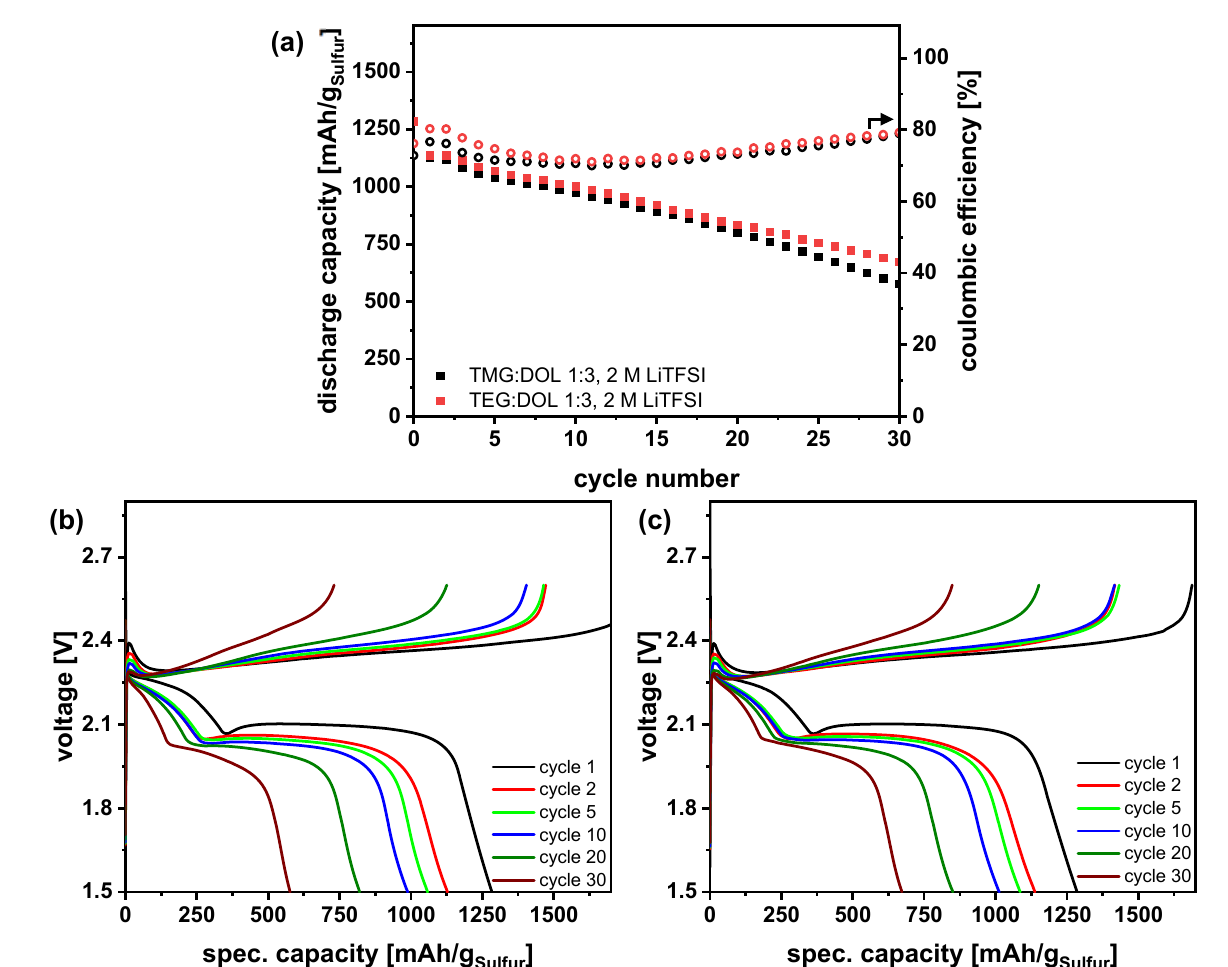
Figure 7. Galvanostatic cycling at 0.1 C and 25 °C in 5-layered Li-S pouchcells of adapted glyoxal- based electrolytes TXG:DOL 1:3 with 2 M LiTFSI with an E:S-ratio of 4.5 µL/mg-S: ( a ) cycle life, ( b ) voltage profiles of TMG:DOL, 2 M LiTFSI, ( c ) TEG:DOL 1:3, 2 M LiTFSI.